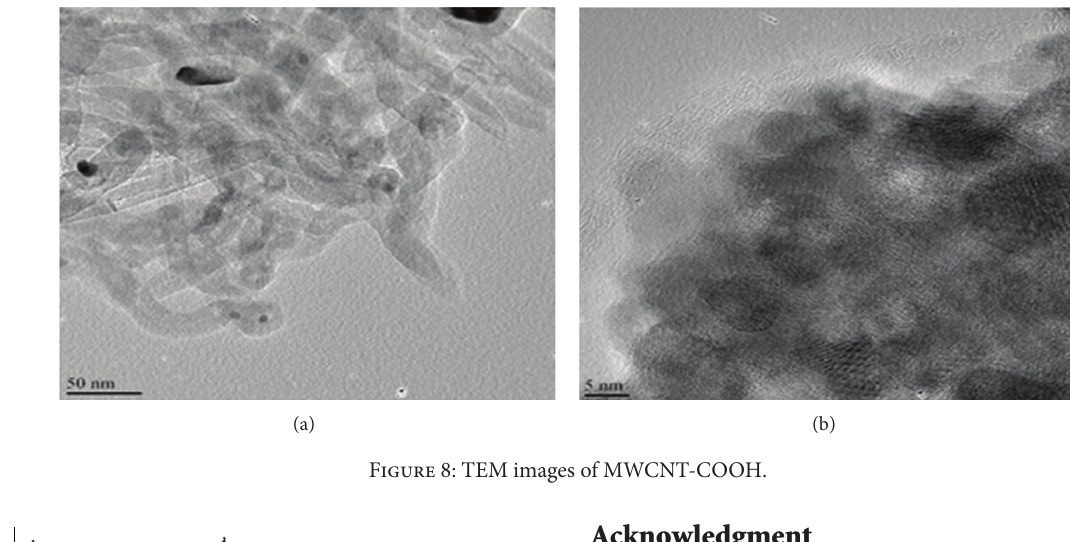
Figure 8: TEM images of MWCNT-COOH.